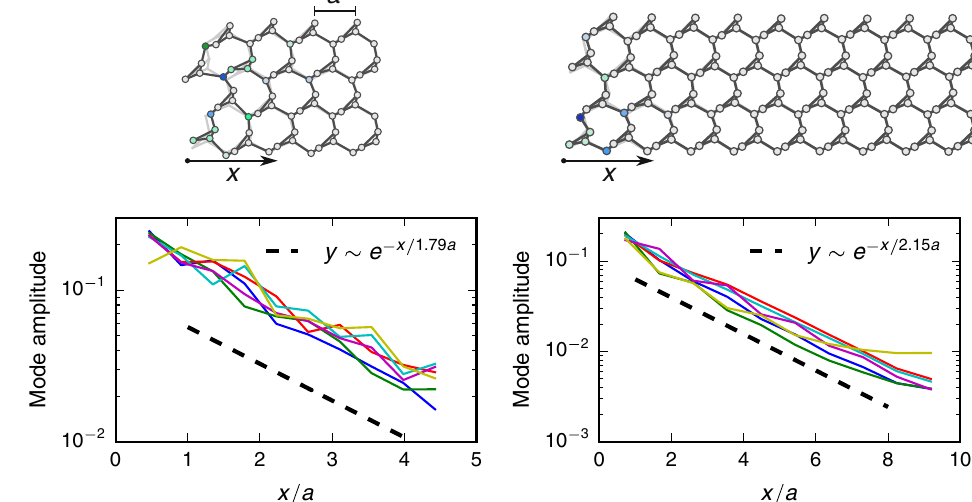
FIG. 6. Decay of displacement amplitudes for nontranslational zero modes as a function of distance from the left edge for systems with free boundaries perpendicular to the x direction and periodic boundary conditions along y . Numerically, eight zero modes are found as predicted by the index theorem. Two of these are the uniform translations, while the remaining six are shown to decay exponentially from the left edge with a decay length comparable to the lattice spacing a . The dashed line is a fit of the sum of the mode amplitudes to a simple exponential decay. Left: System shown in Fig. 2(d). Right: System with twice the separation between the free left and right